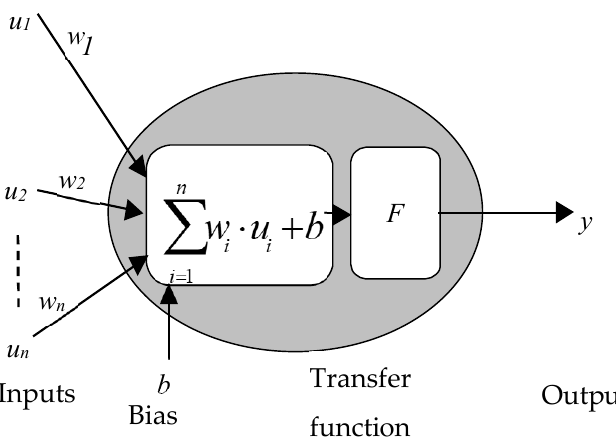
Figure 1. Typical structure of the artificial neuron. The neurons of the ANN are organized in layers, arranged in a successive order for processing data that starts from the input layer and ends with the output layer. The intermediate layers are called hidden layers. The typical topology of a multilayer ANN is presented in Figure